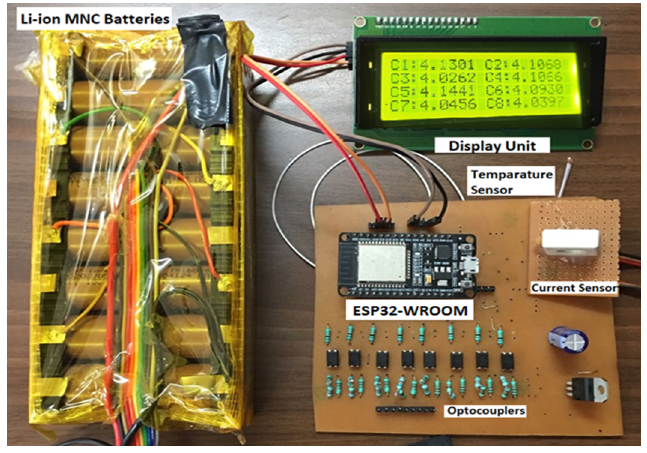
Figure 11. Experimental setup. Table 2. Individual Cell Voltages with Respect to Charge and Discharge State.